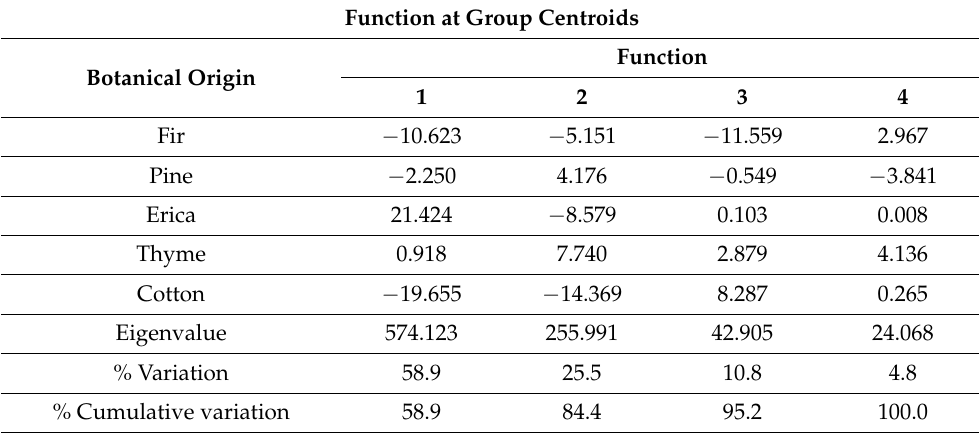
Table 2. Eigenvalues, variation (%), cumulative variation and functions at group centroids exported by